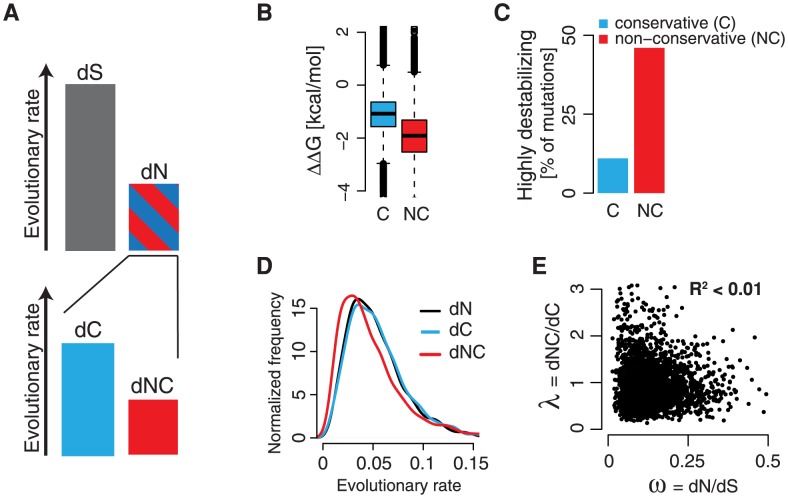
An extended model of protein evolution incorporates the stability effect of mutations.
A Conventionally, protein evolution is described by the rates of non-synonymous substitutions dN, and synonymous substitutions dS, and their rate ratio ω = dN/dS. To accommodate the disparate effect of different amino acid changes on protein stability, the rate of non-synonymous substitutions dN is split into the rates of conservative substitutions dC, and non-conservative substitutions dNC. B Predicted stability effects of conservative (C) and non-conservative (NC) mutations. NC mutations are more likely destabilizing than C mutations. C NC mutations are much more likely highly destabilizing (ΔΔG<−2 kcal/mol) than C mutations. D The evolutionary rate dNC is on average lower than dC and dN, suggesting that NC substitutions are generally under stronger purifying selection. E The evolutionary rate ratios ω = dN/dS and λ = dNC/dC are not correlated, thus independent parameters that contribute orthogonal insights.